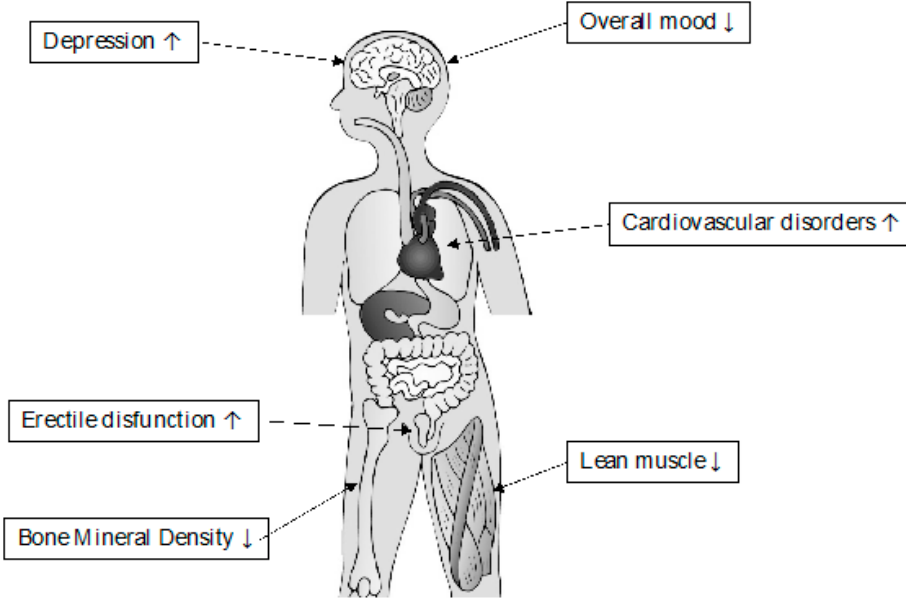
Figure 2. Effects of Testosterone deficiency in the elderly.